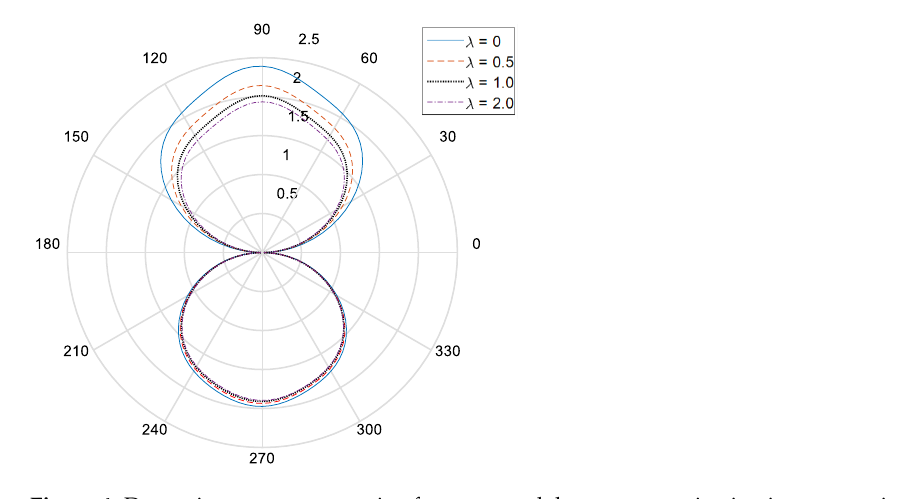
Figure 4. Dynamic stress concentration factor around the upper opening in piezomagnetic composites ( ka = 0.1. d / a = 2.1, λ = (0, 0.5, 1.0, 2.0)).